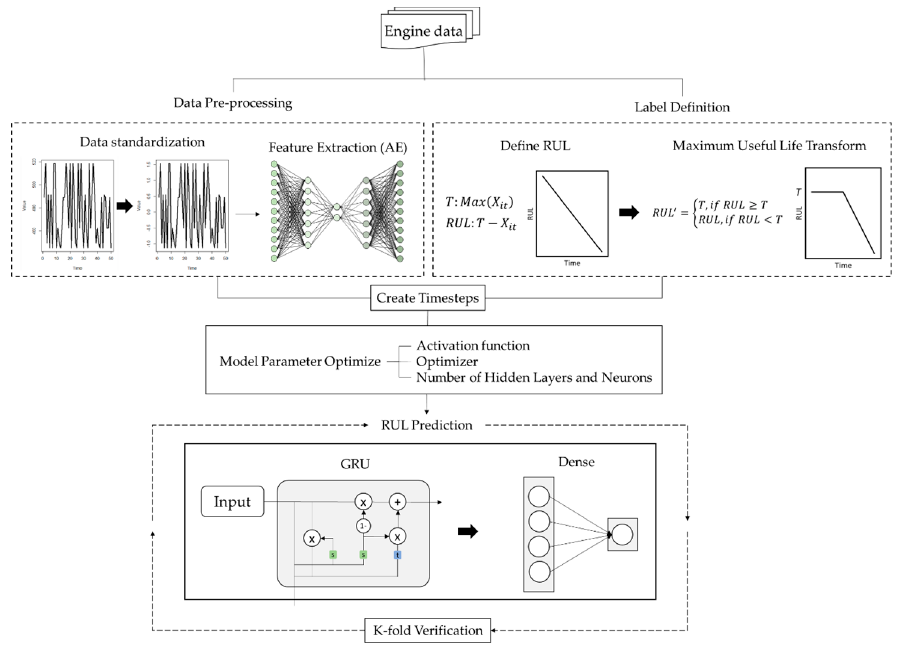
Figure 3. Research framework of Autoencoder Gated Recurrent Unit (AE-GRU).